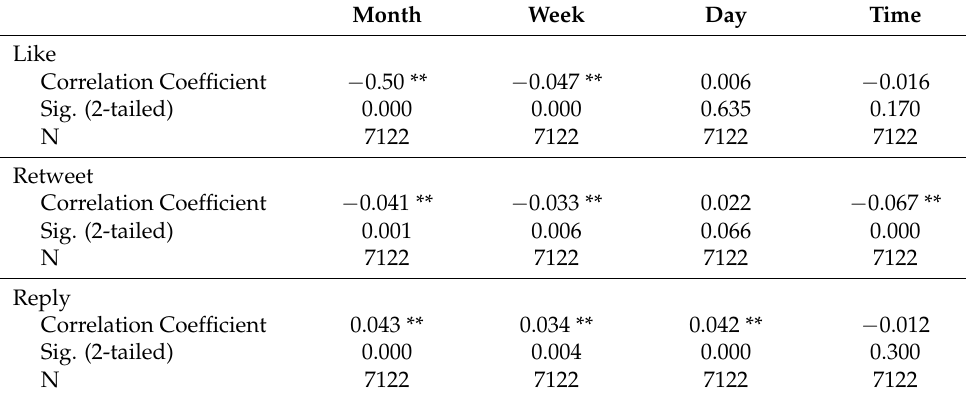
Table 1. Post time correlation